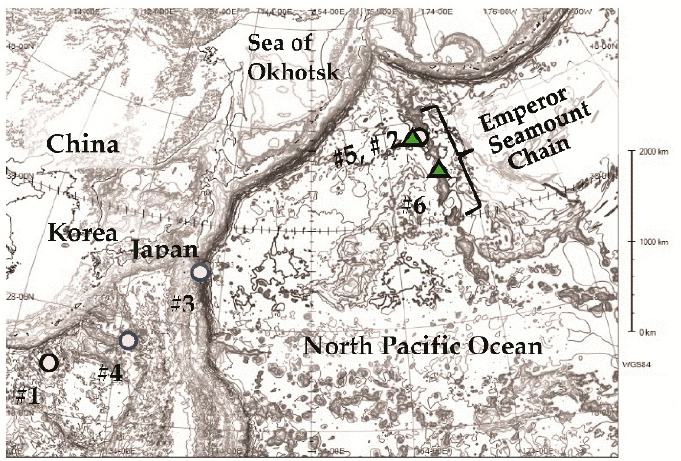
Figure 16. Detail of cable fault locations, see Figures 17 and 18; cable type: LW: ◦ , LWS: ▲ ; isobaths: the isobaths are shown, based on GEBCO (General Bathymetric Chart of the Oceans Edition 2003), and thin black isobaths show 500 m interval.